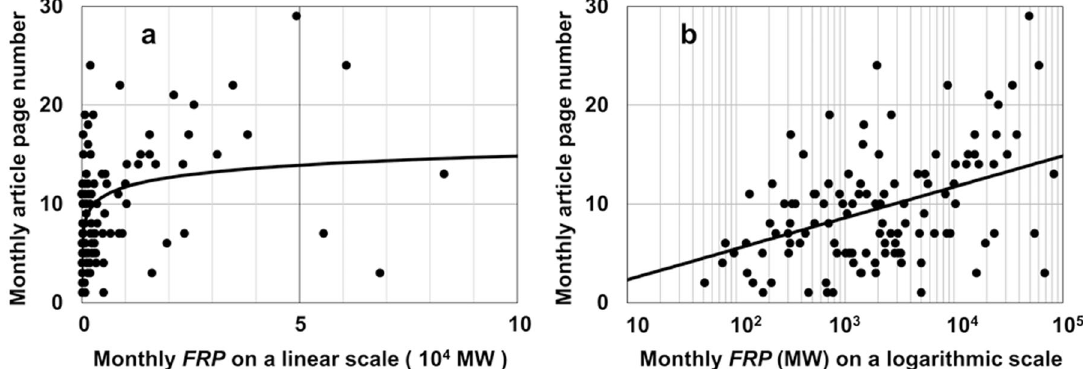
Fig. 4 Correlation diagrams of monthly data during 2009 – 2018. Article page number of “ peatland fi re ” vs . FRP . The article number is on a linear scale while FRP is on a a linear scale or b a logarithmic scale. The solid line in b is a best- fi t with R = 0.43, which corresponds to the solid curve in a